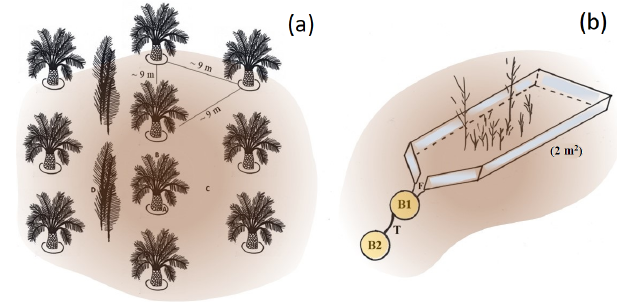
Figure 1. (a) Triangular planting arrangement on smallholder oil- palm plantations in the study area (sketch by Britta Greenshields). Topsoil samples were taken in four distinct management zones: (A) palm circles, (B) oil-palm rows, (C) interrows, and (D) below frond piles. (b) This is a 2m 2 sediment trap with scarce understorey vegetation installed in pairs in four well-drained plots (sketch by Britta Greenshields following Sinukaban et al., 2000). The downs- lope funnel-shaped part of the aluminium frame (F) directs surface runoff, together with eroded soil material, into a bucket (B1) that is connected to a second bucket (B2) by a 2cm wide tube (T). Photos of the sediment traps are shown in the Appendix Table